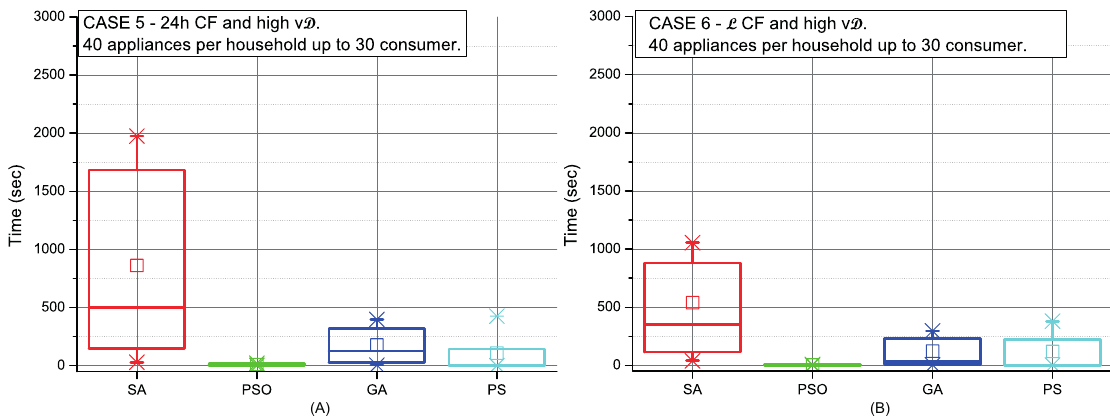
Figure 8. Comparison of the SA, PSO, GA and PS methods for both high variable and fixed consumption in 24 h CF ( A ) and L CF ( B ).